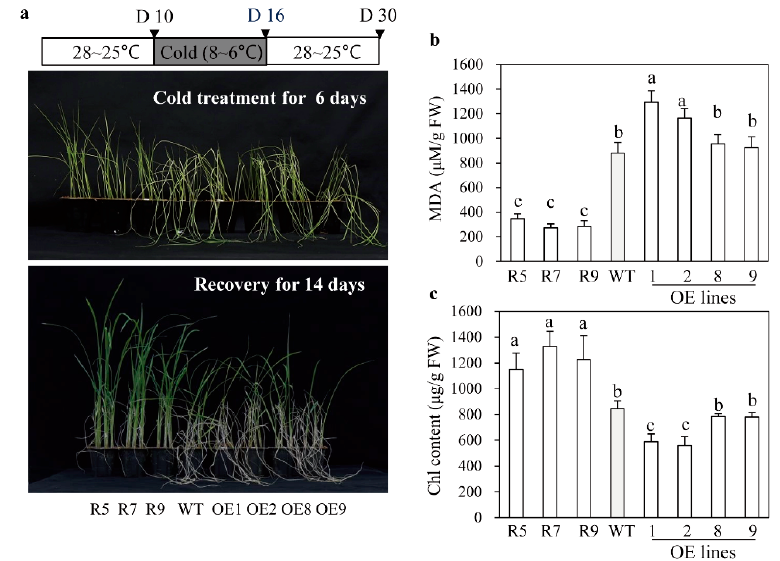
Figure 7. Response to cold treatment. ( a ) Rice seedlings after cold treatment and recovery from cold stress. ( b ) MDA content. ( c ) Chlorophyll content. Ten-day-old rice seedlings were exposed to cold stress at 6–8 °C for 6 days and then allowed to recover for 14 days at 25–28 °C. D denotes the time